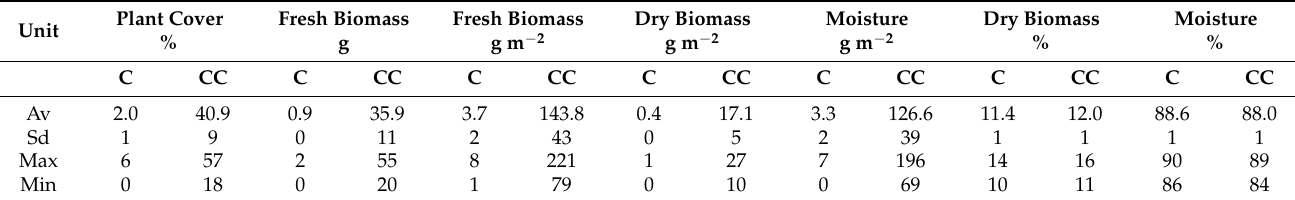
Table 2. Plant cover, biomass (fresh and dry), and moisture values. C: Control plot; CC: Catch crop plot. Av: Average; Sd: Standard deviation; Max: Maximum; Min: